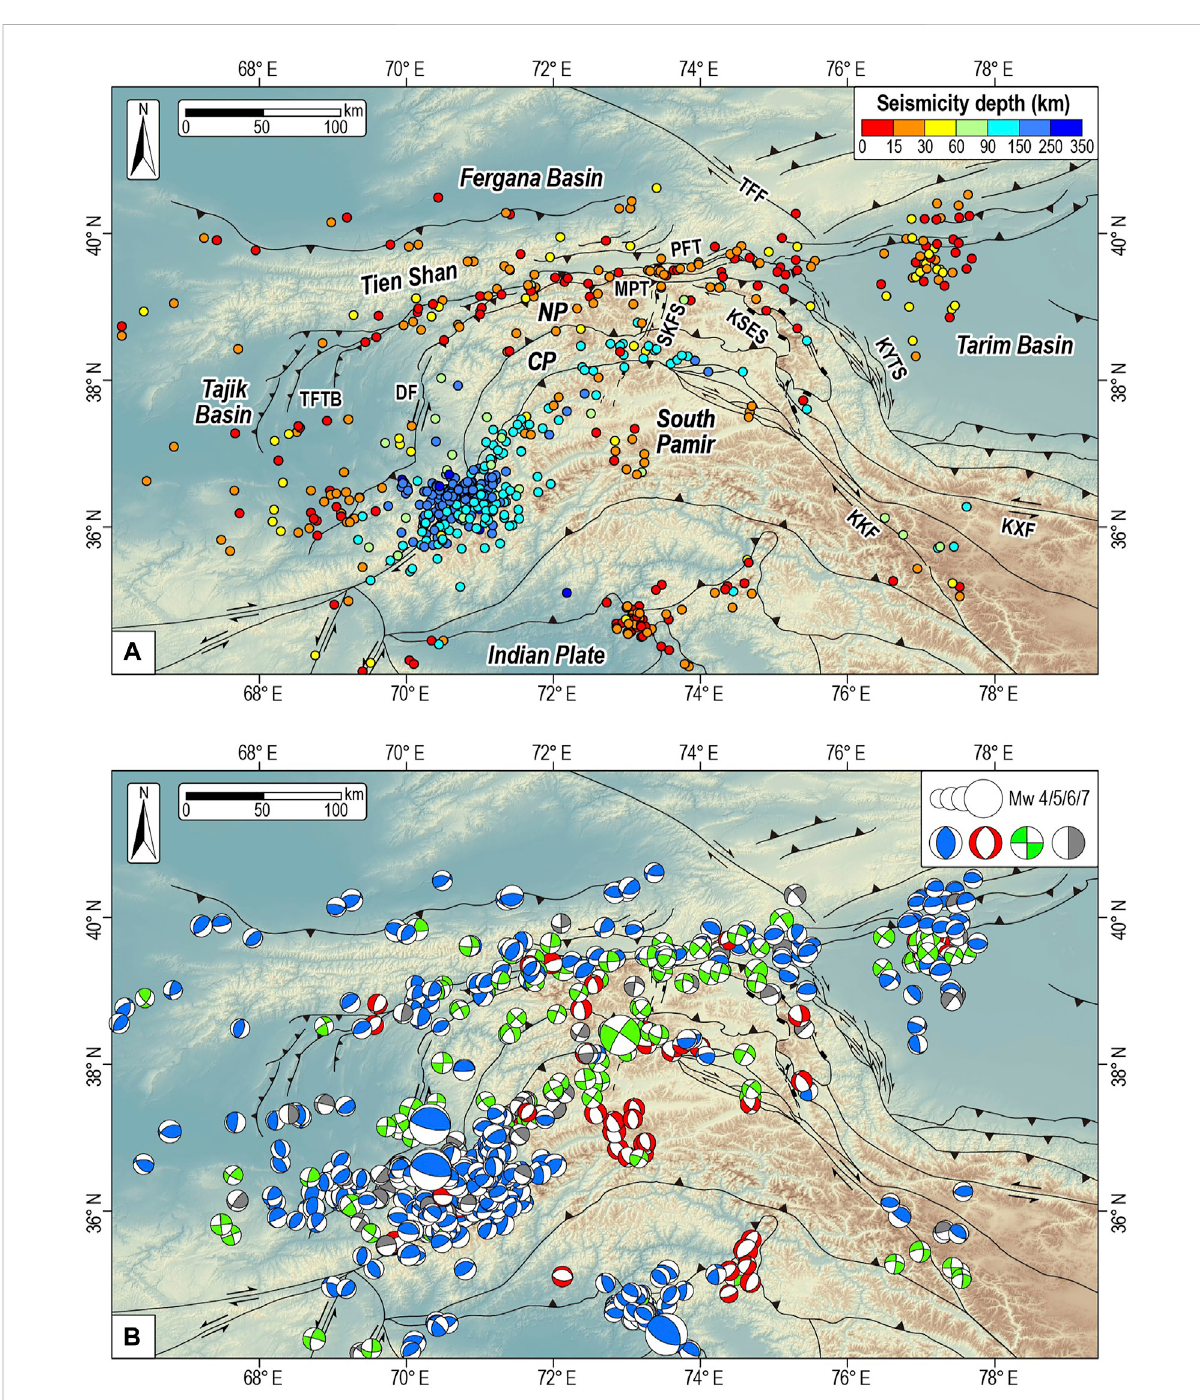
FIGURE 7 Seismicity of the Pamir salient and its adjacent regions. (A) Earthquake focal depth. (B) Focal mechanisms. Blue, red, and green beachballs represent the thrust, normal-fault, and strike-slip earthquakes, respectively. The earthquake data are from Global Centroid Moment Tensor Catalog (GCMT). Fault names same as Figure 1. NP, North Pamir; CP, Central